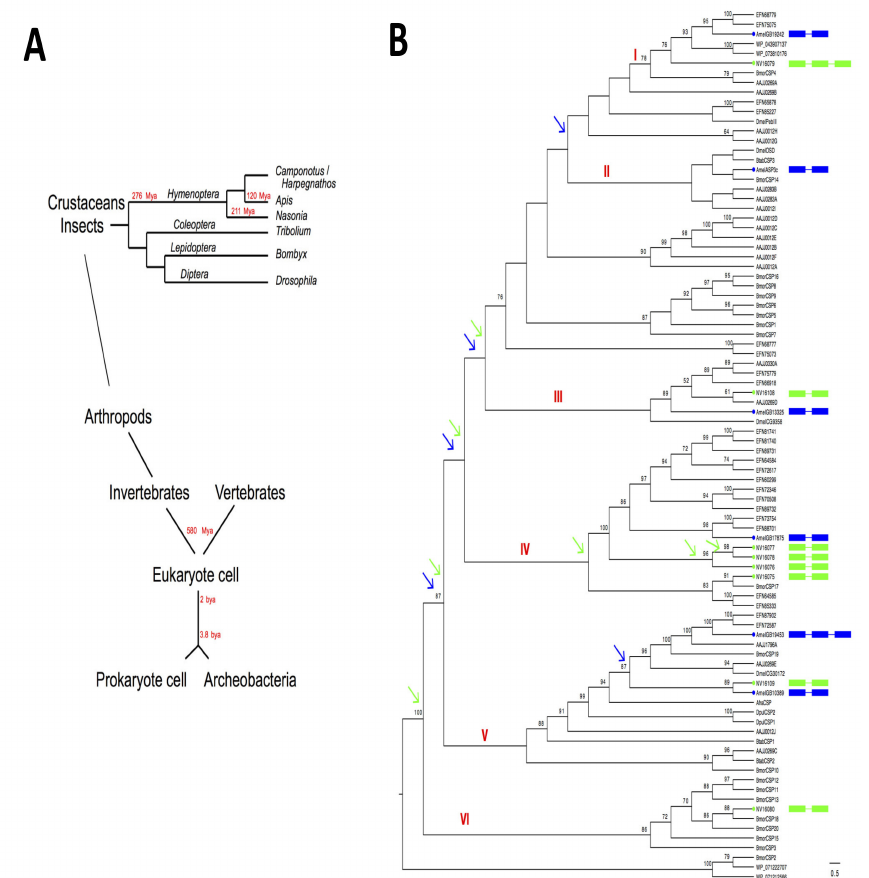
Figure 3. Schema of relationships from bacteria to insects and amino acid phylogenetic analysis of Apis and Nasonia CSPs . ( A ) Timeline of the evolutionary history of life from bacteria and prokaryote cells to multiple species of insects. ( B ) Gene phylogeny and orthology groups of bacterial / insect CSPs with focus on gene duplication profiling in honeybees and jewel wasps. Bacteria: Acinetobacter (WP_071212566, WP_071222707); Kitasatospora (WP_04307137, WP_07383810176) [29,30]. Insects: ants (EFN), beetles (AAJJ), flies (Dmel), moths (Bmor) and whiteflies (Btab) [12–15,37,38,44–46]. Crustacean: A. franciscana (AfraCSP; ABY62736, ABY62738); D. pulex (DpulCSP1, DpulCSP2; ABH88167, ABH88166). Phylogenetic trees are generated from a total of ninety protein sequences (IQ-TREE, UFBoot; 1000 replicates). Blue and green color circles represent Apis mellifera ( Amel ) and Nasonia vitripennis ( NV ) protein sequences, respectively. The gene structures are shown on the right for Amel (in blue) and NV (in green) CSPs . Branches are shown supported by > 50% bootstrap value. Six major orthology groups are found corresponding to specific Amel and NV CSP sequences: group I (AmelGB19242, NV16079); group II (AmelASP3c); group III (AmelGB13325, NV16108); group IV (AmelGB17875, NV16075, NV16076, NV16077, NV16078); group V (AmelGB10389, AmelGB10453, NV16109); group VI (NV16080). Blue and green arrows indicate gene duplication